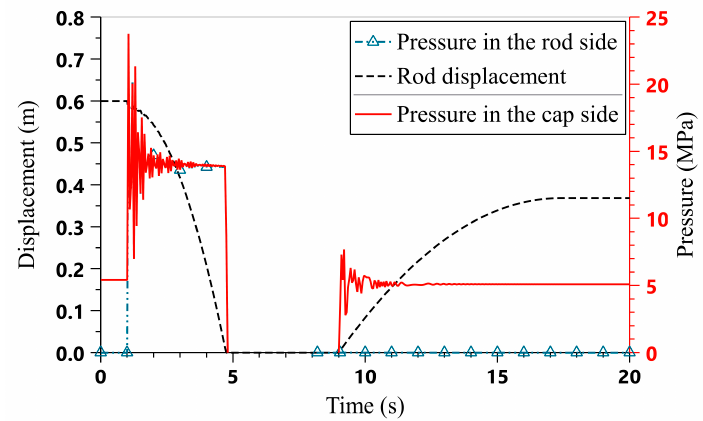
Figure 14. The boom cylinder displacement and the pressures of the boom cylinder of the FFERS.